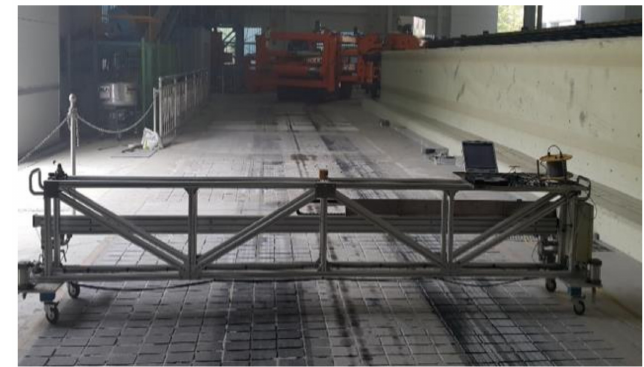
Figure 4. Transverse profile logger.